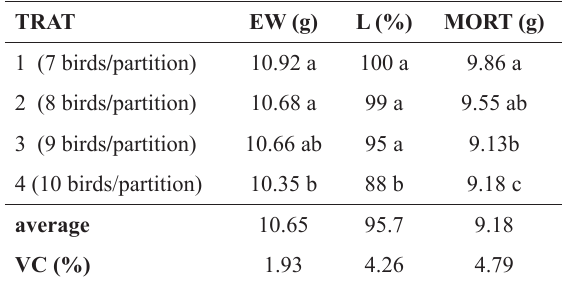
Densities effect over egg weigh (EW) specific gravity (SG), egg color (EC), shell thickness ( ST) and Haugh Unit